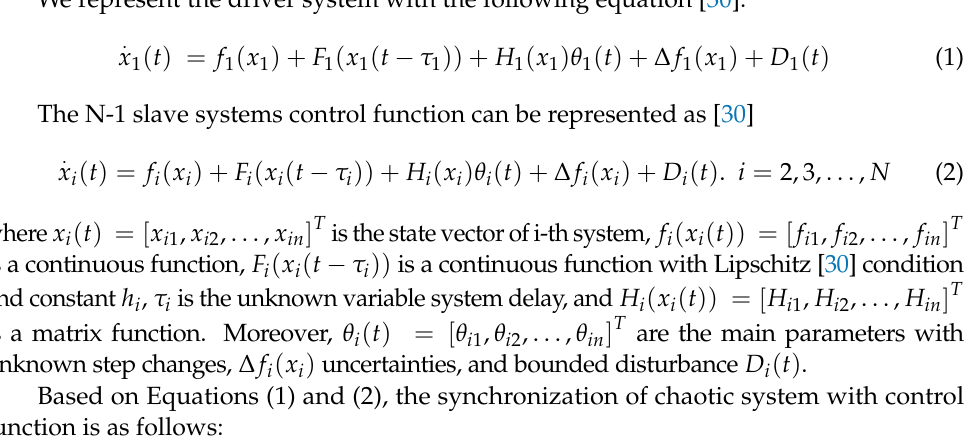
Figure 1. Synchronization of the master system with multiple slave systems.